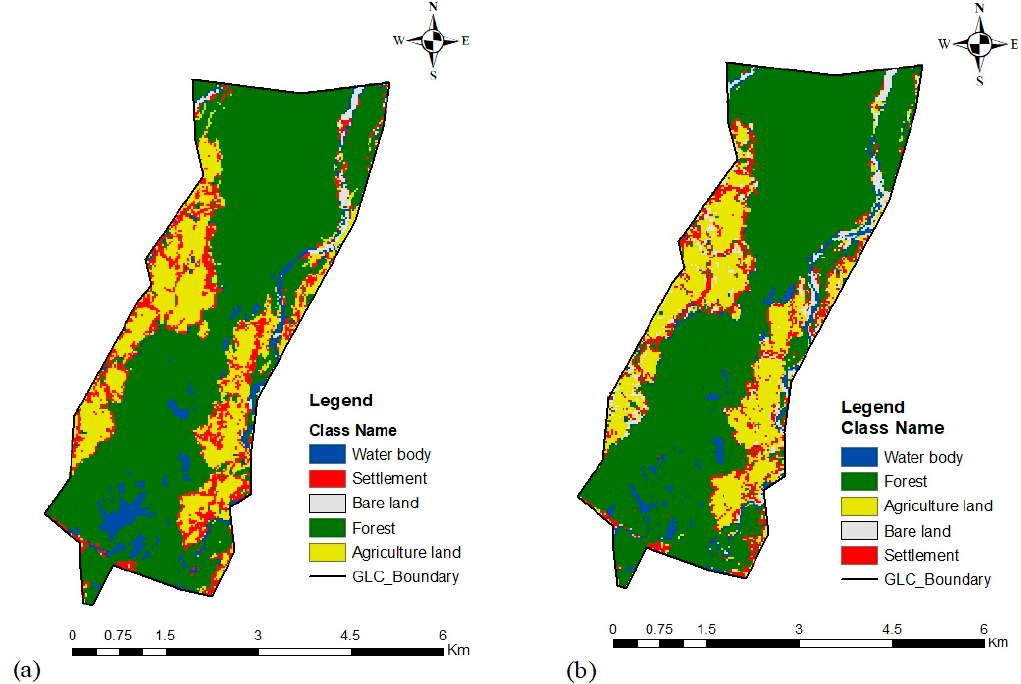
Figure 5. Classified land use and land cover (LULC) map of Ghodaghodi Lake Complex, Nepal, 2022 data. ( a ) LULC map in April, ( b ) LULC map in November.